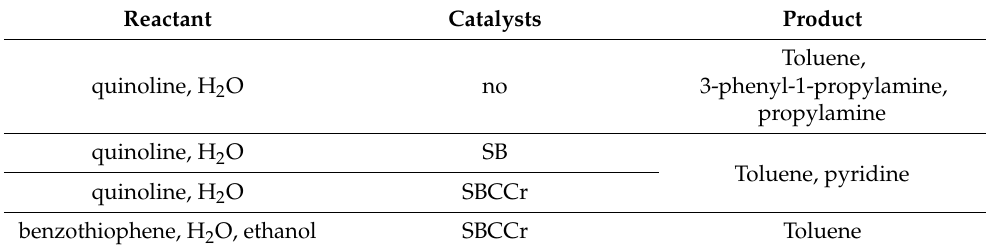
Table 8. New compounds of quinoline under different reaction conditions.